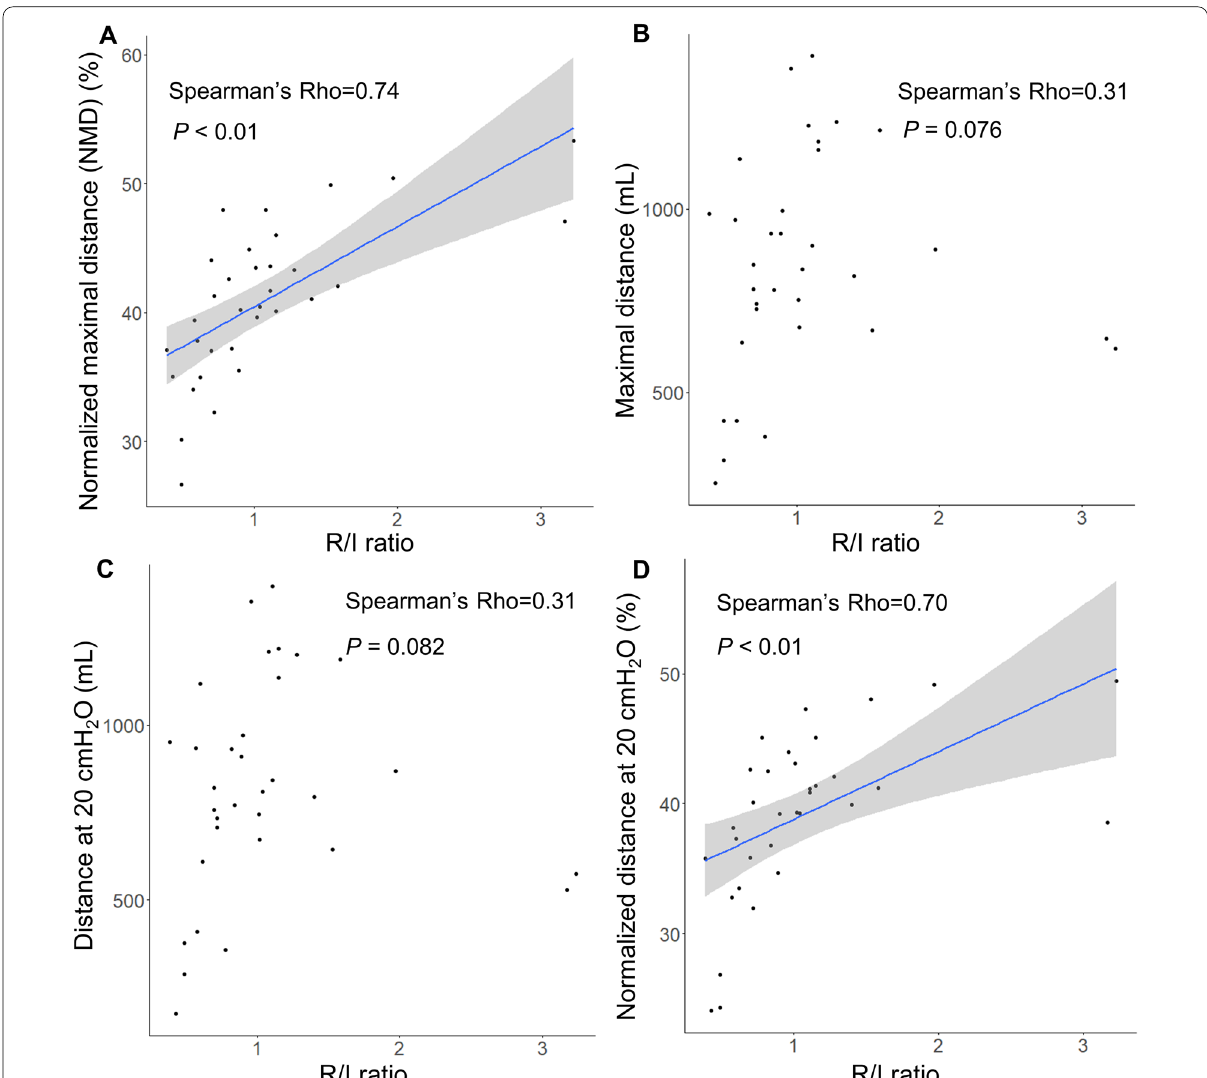
Fig. 3 Correlation between the items of the different recruitability indicators. A The correlation between the items of the different recruitability indicators showing a significant correlation between the recruitment-to-inflation ratio (R/I ratio) and the normalized maximal distance (rho P < 0.001). B The relationship between the maximal distance and the R/I ratio (rho R/I ratio (rho 0.31, P 0.082) were not correlated. D Moderate correlation was observed between normalized distance at 20 cm H 2 O and the R/I = = ratio (rho 0.70, P < =